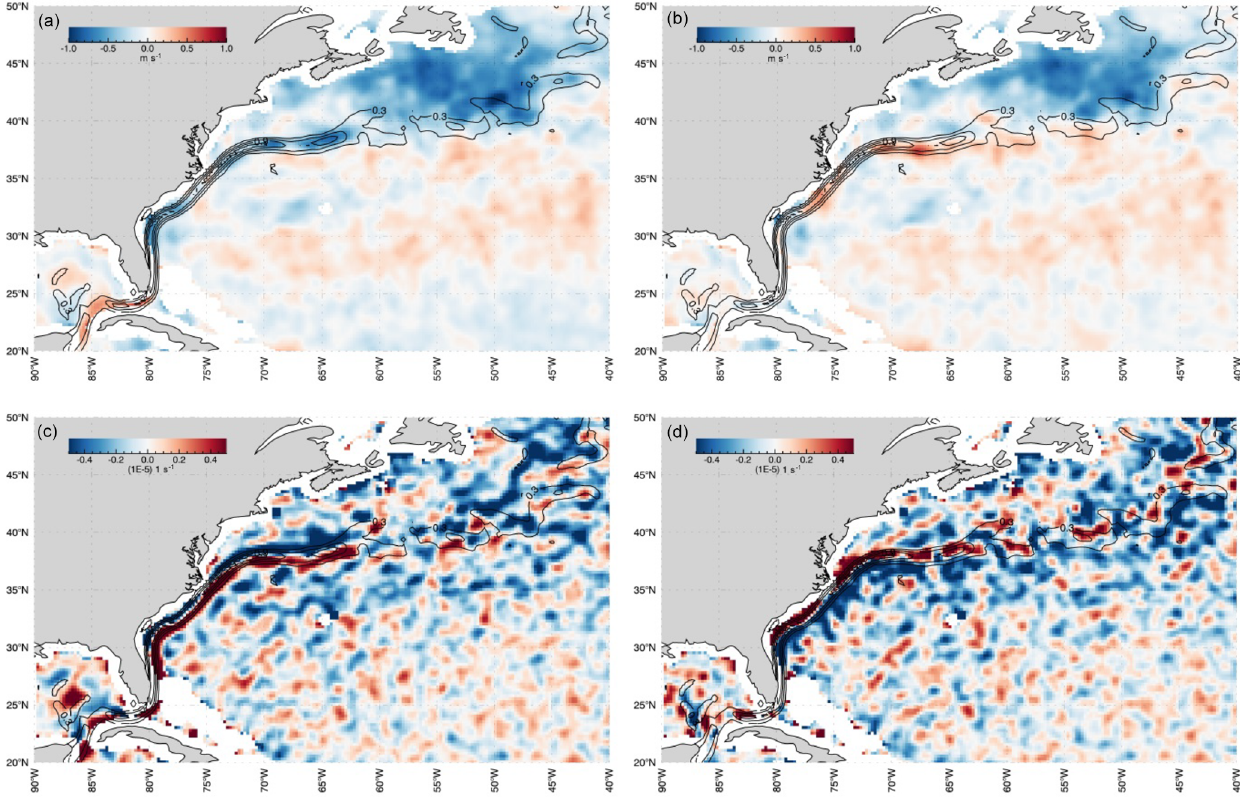
Figure 17. Gulf Stream: annual differences in mean wind speed (a, b) and mean stress curl (c, d) between ASCAT and ERA5 before (a, c) and after (b, d) the ocean current correction. The contours are annual mean ocean surface velocities.